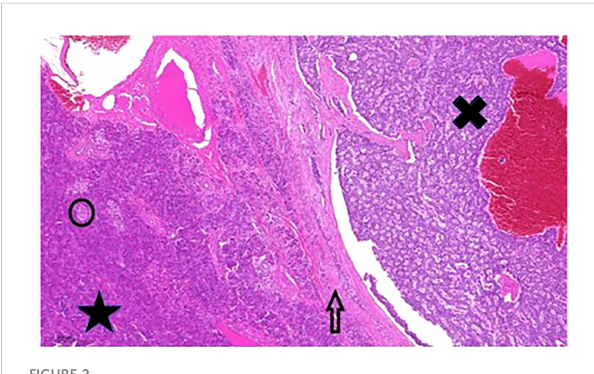
FIGURE 2 Pancreatic tumour histology. Large well-circumscribed tumour (black X) adjacent to normal pancreas tissue (black star). The arrow points to the fi brotic capsule-like pushing border zone ” . The black circle contains one of the Langerhans islands. Hematoxylin and eosin stain, 200x magni fi cation.